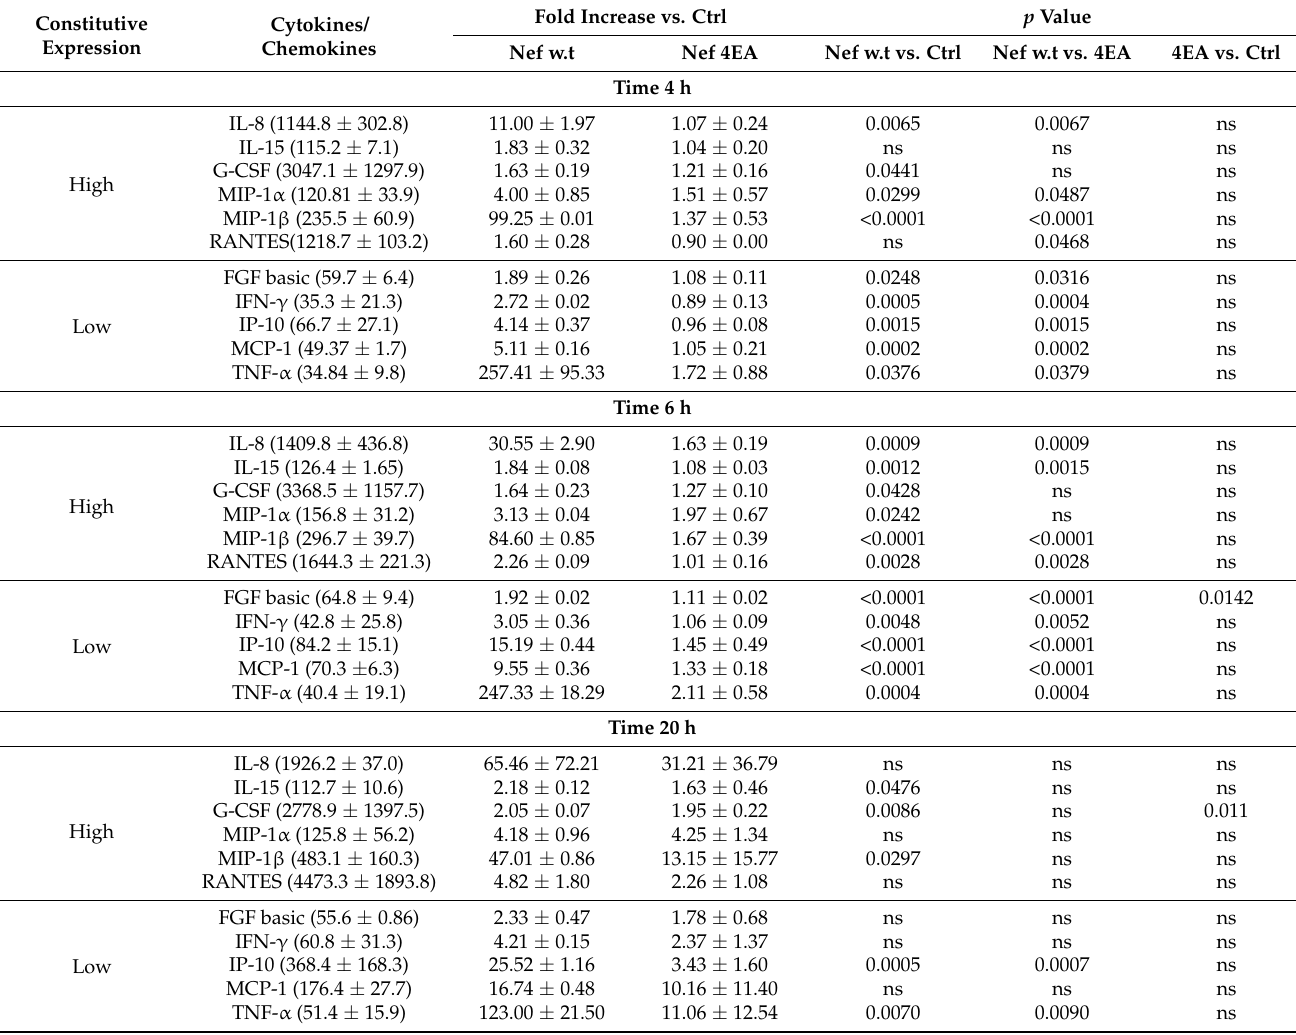
Table 2. Cytokines/chemokines released by THP-1/PMA cells in response to